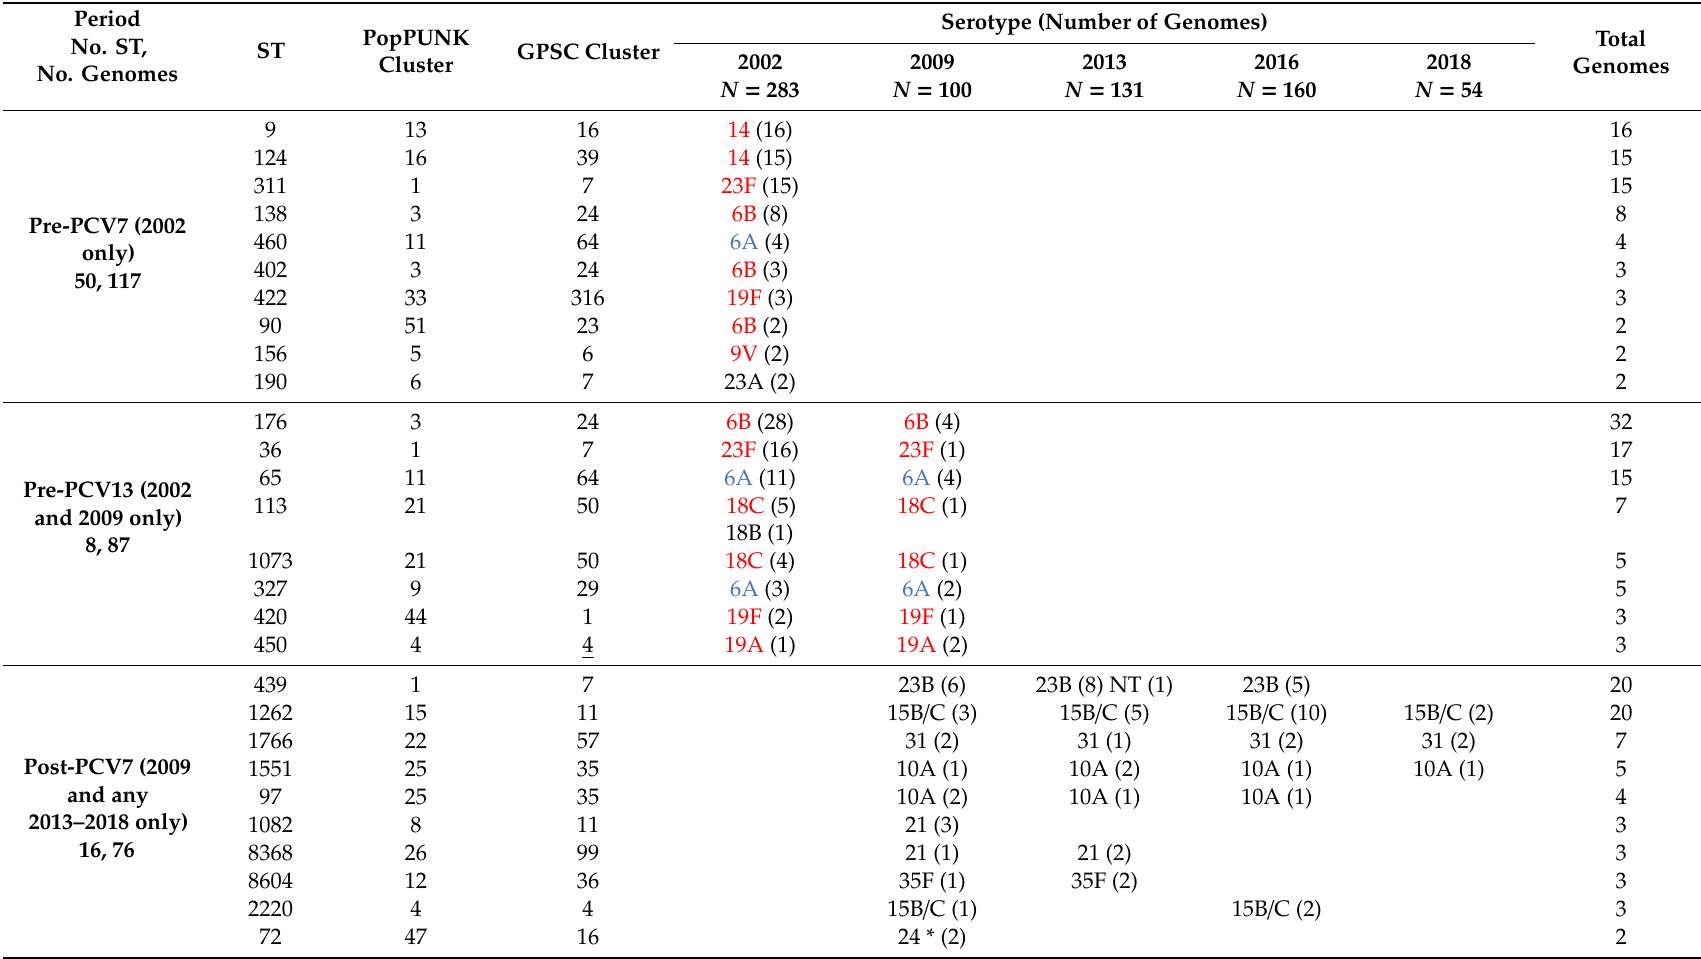
Table 3. Numbers and serotypes of top 10 most frequent ST seen in each period in relation to vaccine implementation, with local PopPUNK cluster and Global Pneumococcal Sequencing Cluster (GPSC) cluster (de-duplicated